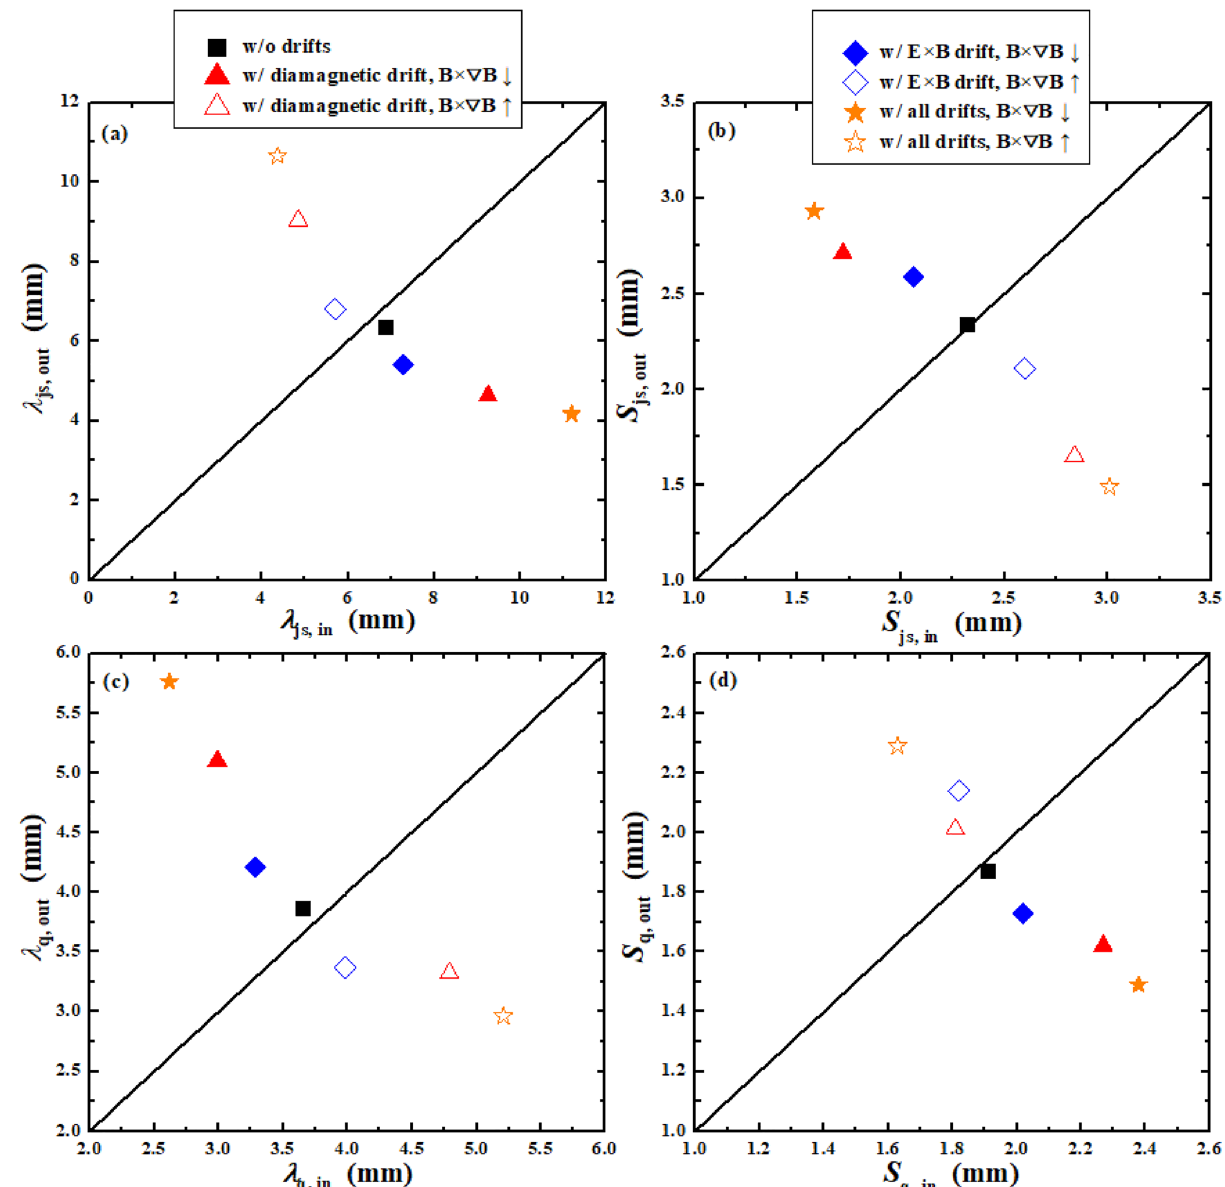
Figure 10. The particle and heat flux decay widths (cid:31) js and (cid:31) q , and the particle and heat spreading widths S js and S q at the outer target, versus the counterparts at the inner